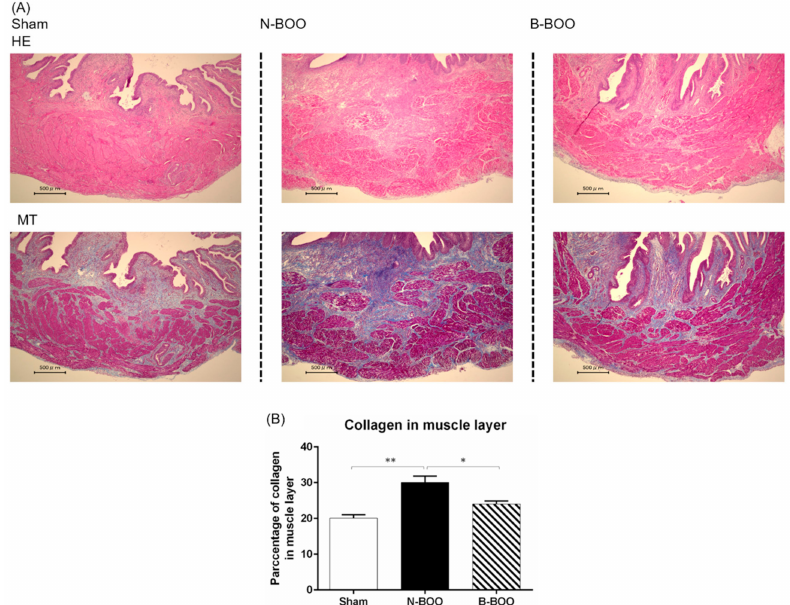
Figure 3. Histological analysis of the bladder tissue from Sham, N-BOO and B-BOO group rats. ( A ) Hematoxylin–Eosin staining (HE) is shown in the upper row and Masson trichrome stain (MT) in the lower row. ( B ) Mean ± SE of 6 determinations each of the percentage of collagen in muscle layer of Sham, N-BOO and B-BOO group rat bladders. A single asterisk indicates p < 0.05. Double asterisks indicate p <